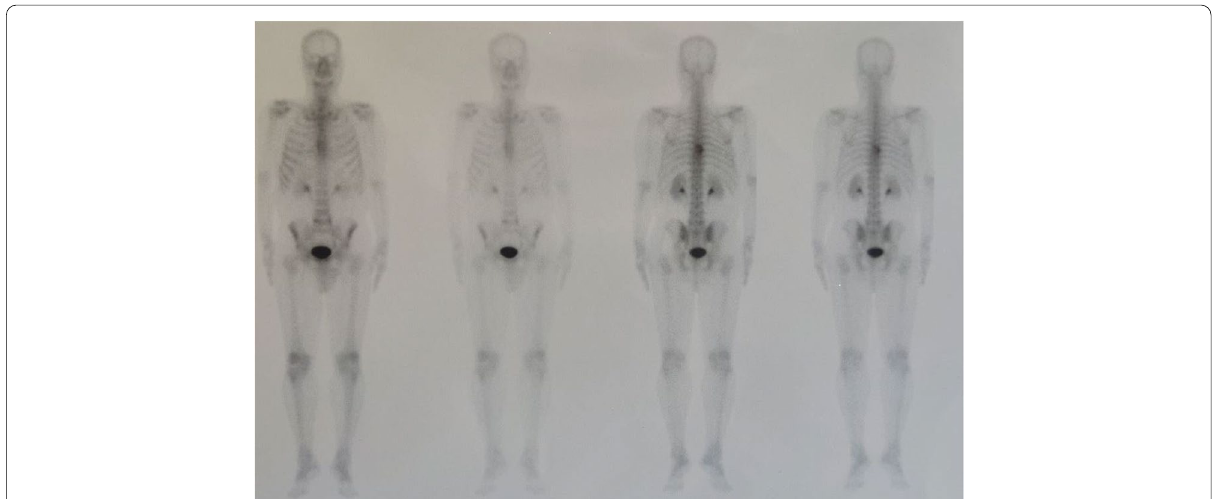
Fig. 2 Whole-body bone scintigraphy using Tc-99 MDP showed increased tracer uptake in T7 and T8 vertebrae. Tc-99 MDP, technetium 99-methyl